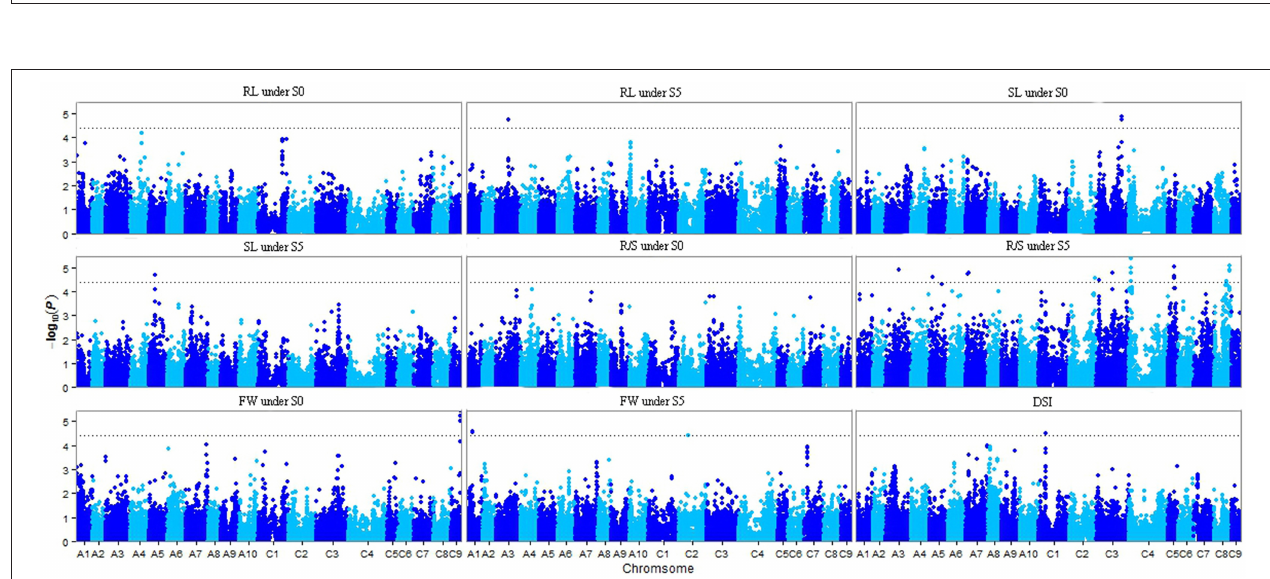
FIGURE 3 | Manhattan plots resulting from GWAS results for drought stress index and four traits under normal (S0) and water stress (S5) conditions. Root length (RL) under S0 and S5; Shoot length (SL) under S0 and S5; Root to shoot length ratio (R/S) under S0 and S5; Fresh weight (FW) under S0 and S5; Drought stress index (DSI). The dashed horizontal line depicts the significance threshold ( P < 3. 92 × 10 − 5 ).